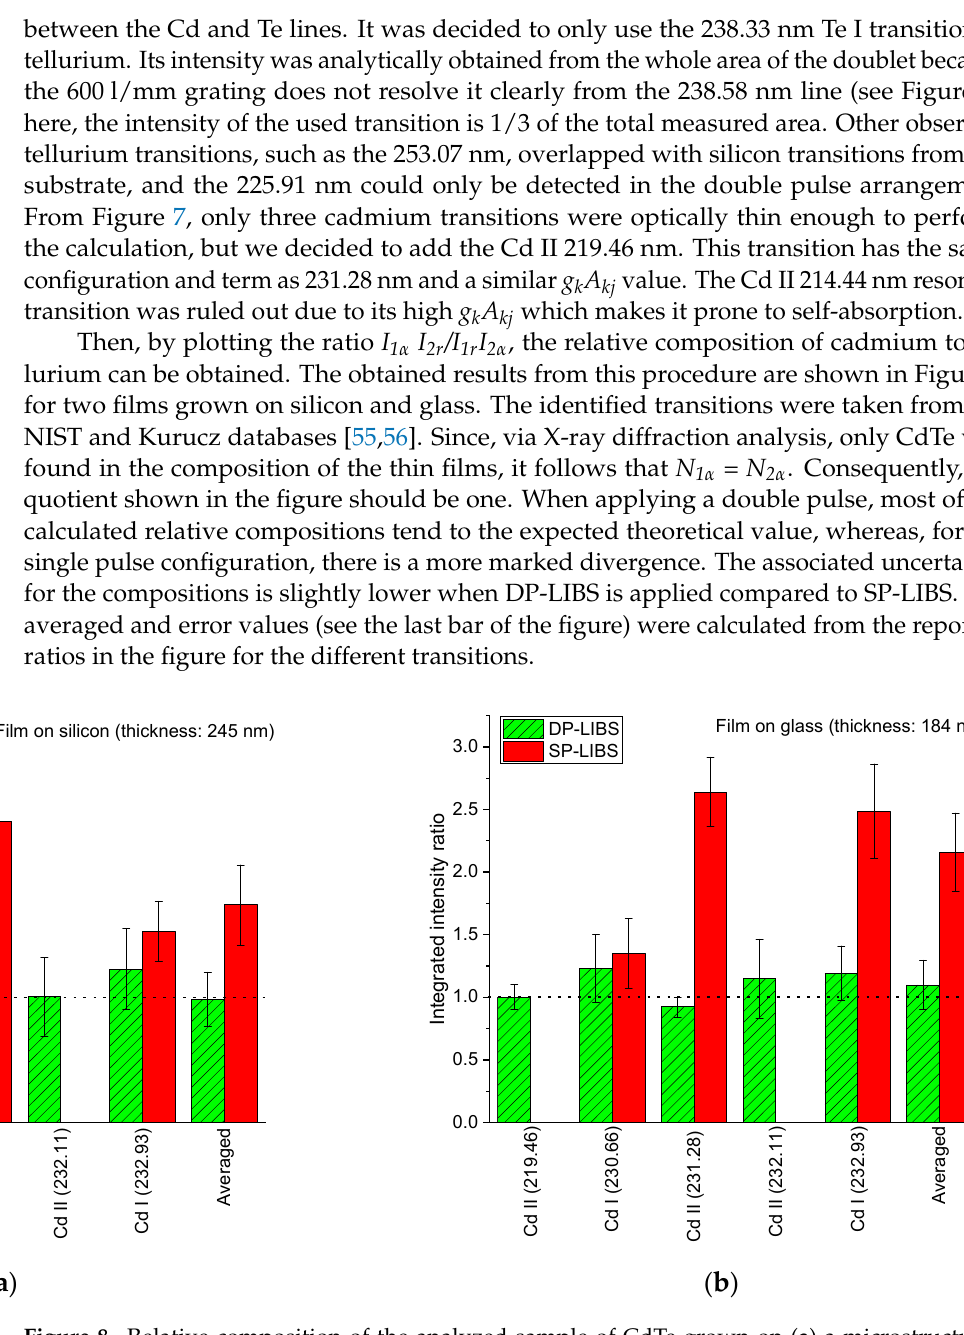
Figure 8. Relative composition of the analyzed sample of CdTe grown on ( a ) a microstructured crystalline silicon substrate and ( b ) a glass substrate. Wavelengths are given in nanometers and the 238.33 nm from Te I was taken as reference.